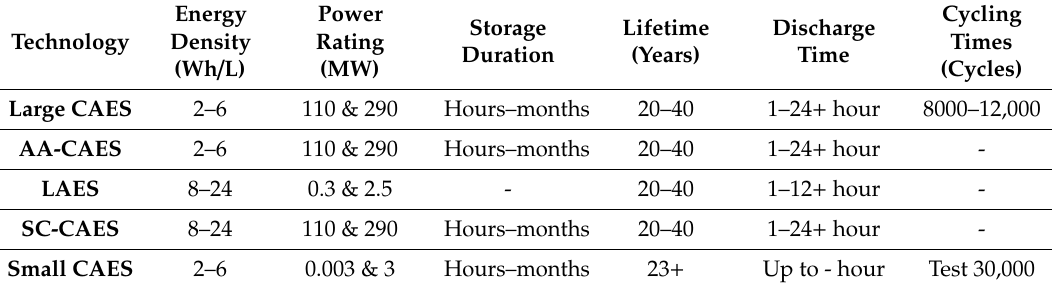
Table 3. Comparison among di ff erent CAES technologies [36].